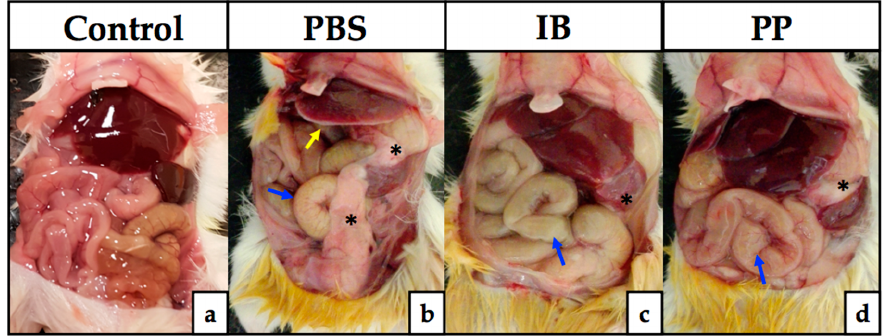
Figure 1. Clinical evaluation of the pathology in peritoneum organs. The development of inflammation of the intestine (blue arrow), appearance of necrotic foci in the liver (yellow arrow), and fibrosis formation around the spleen (black asterisks) are signs of parasite infection on the seventh day post-infection, being more evident in the group treated with PBS ( b ) with respect to those treated with viable Lactobacillus casei ( c ) and non-viable Lc ( d ), when compared to healthy mice ( a ). PBS) phosphate buffered saline; IB) immunobiotic; PP) paraprobiotic.